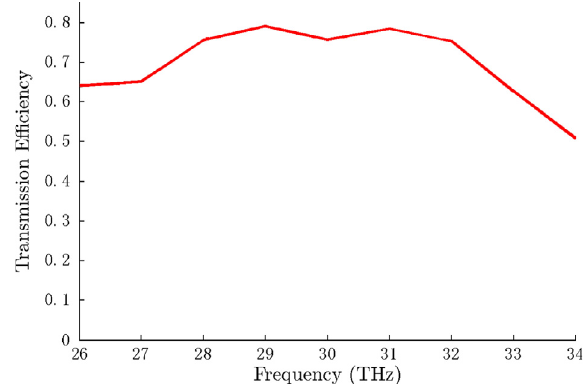
Figure 5. Over 70% transmission efficiency can be maintained over the frequency range of 28–32 THz. This is equivalent to 14% bandwidth.